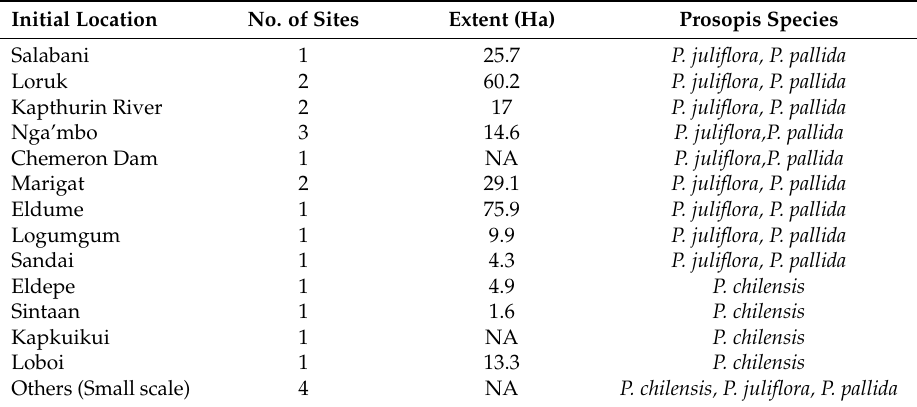
Table 1. Summary of initial Prosopis plantations in Baringo county, extent of the site and species, based on the work of Andersson